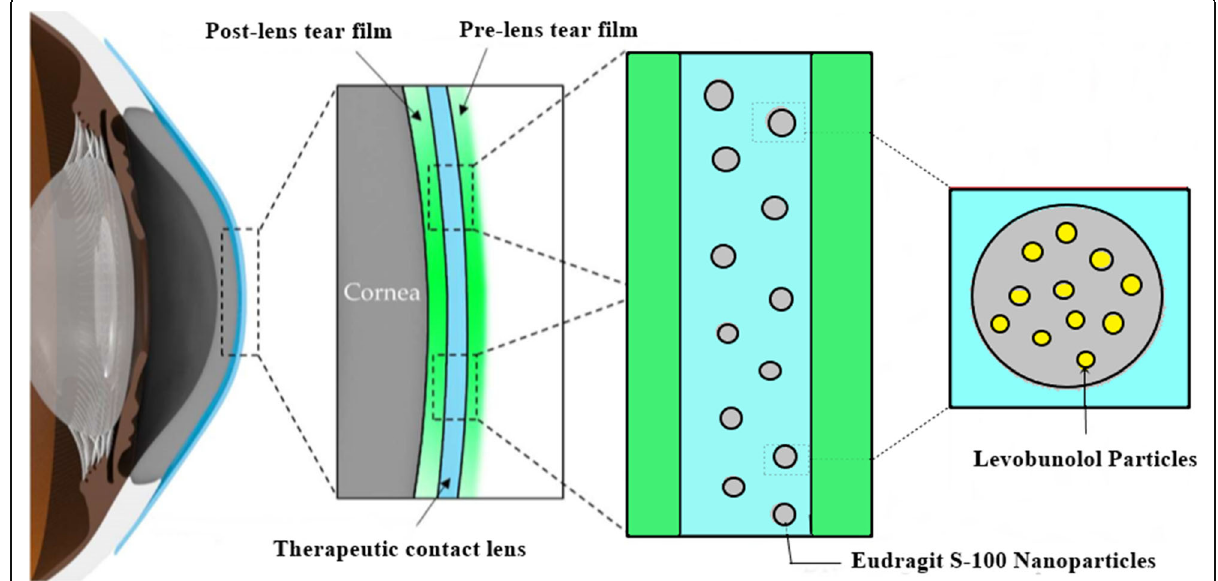
Fig. 1 Schematic diagram of drug-eluting therapeutic contact lens containing LB-loaded polymeric